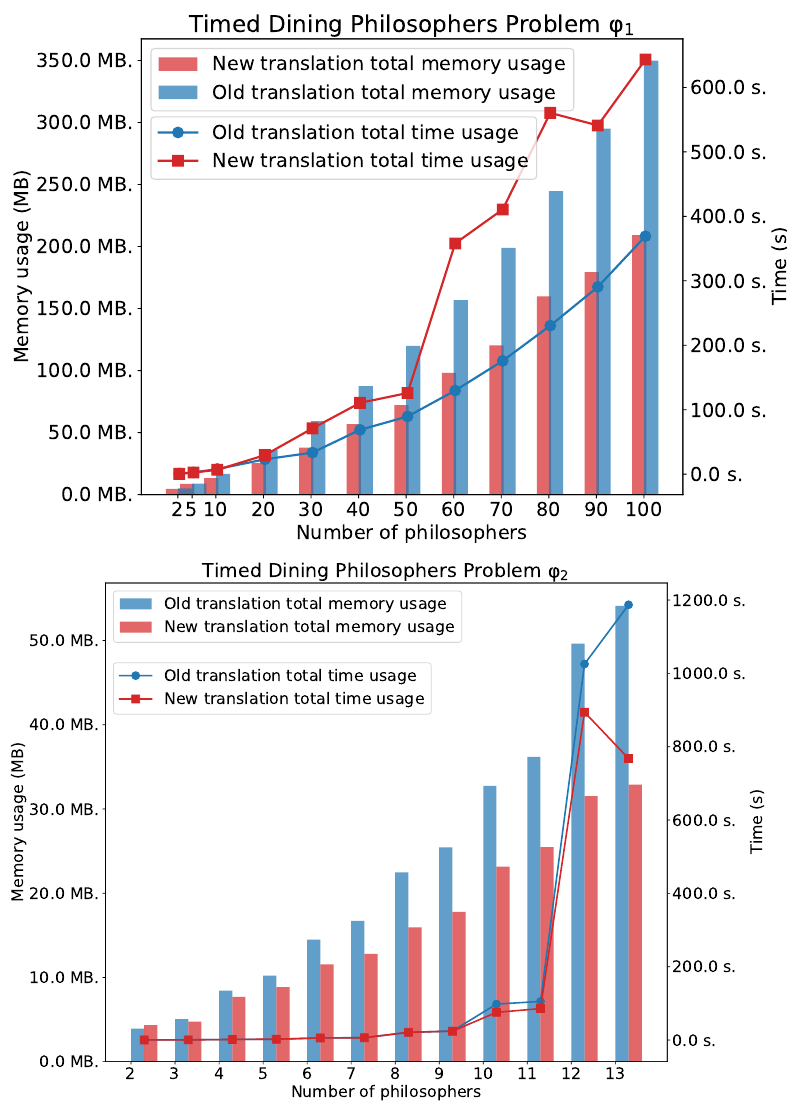
Figure 5. TDPP with n philosophers: ϕ 1 and ϕ 2 . Figure 6 shows experimental results for ϕ 3 .